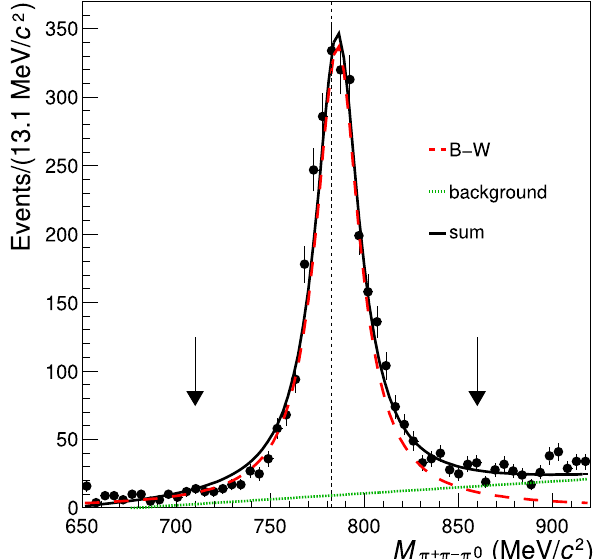
Fig. 3 Distribution of the π + π − π 0 invariant mass fitted by a Breit- Wignerfunctionandlinearbackground.Thedashedverticallinedenotes thePDGvalueofthe ω mass.Theblackarrowsdenotetheappliedlimits